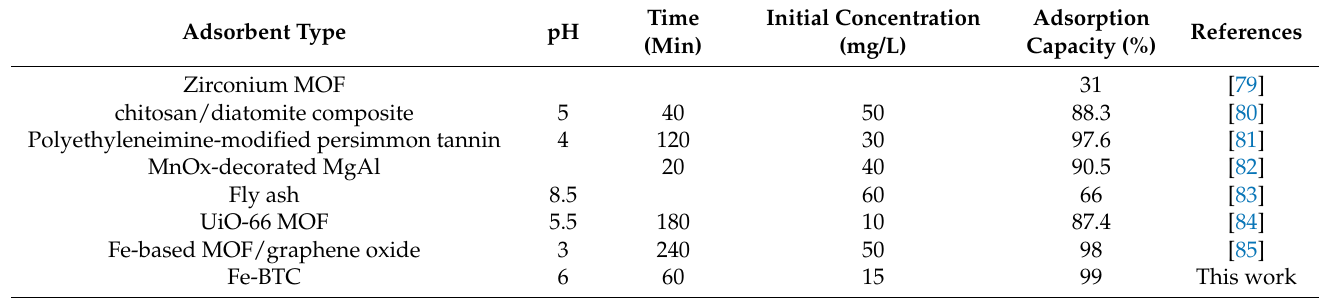
Table 5. Adsorption performance of MO with other